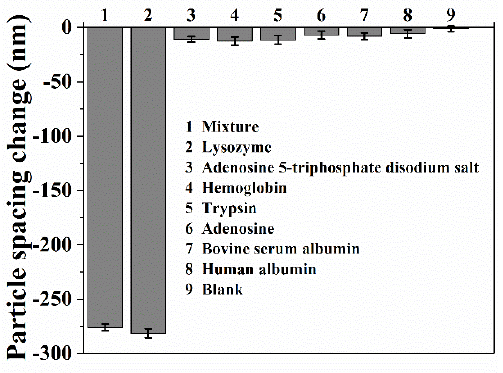
Figure 5. The particle spacing changes of the DNA − H1 − 960 after treatment with various solutions of 500 μM. The particle spacing decreases of the sensor in lysozyme and the mixture solution (1 Mixture, prepared by mixing the compounds 2–8 listed in this figure) were much higher than those in the other biomolecules’ solutions. The results showed the high detection selectivity and anti-interference of the DNA − H1 − 960 to lysozyme.